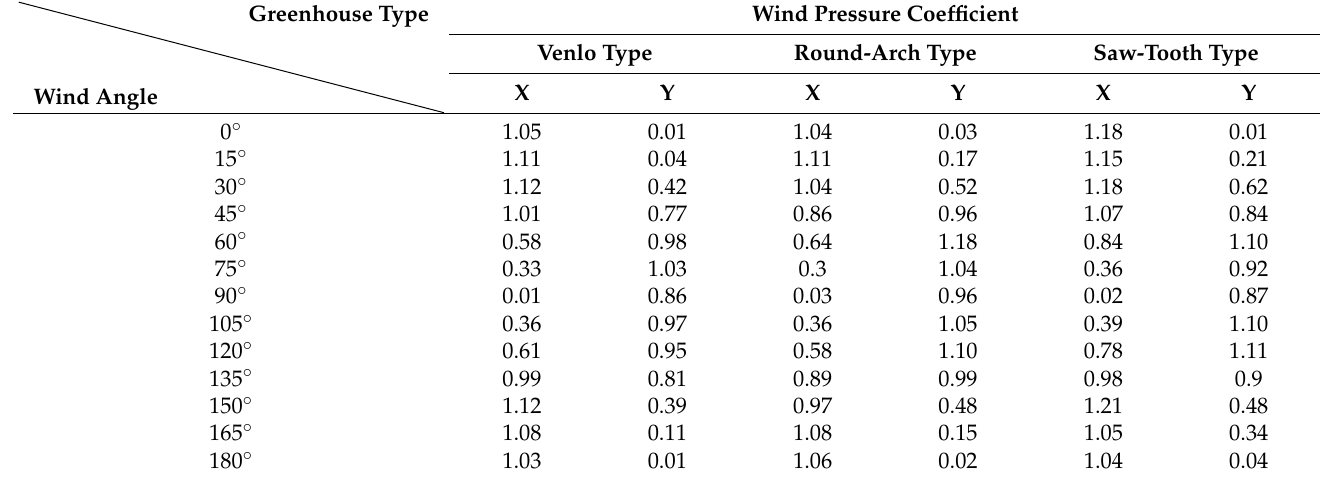
Table 6. Average wind pressure coefficients for the respective greenhouse in the X/Y direction at different wind angles in roof and